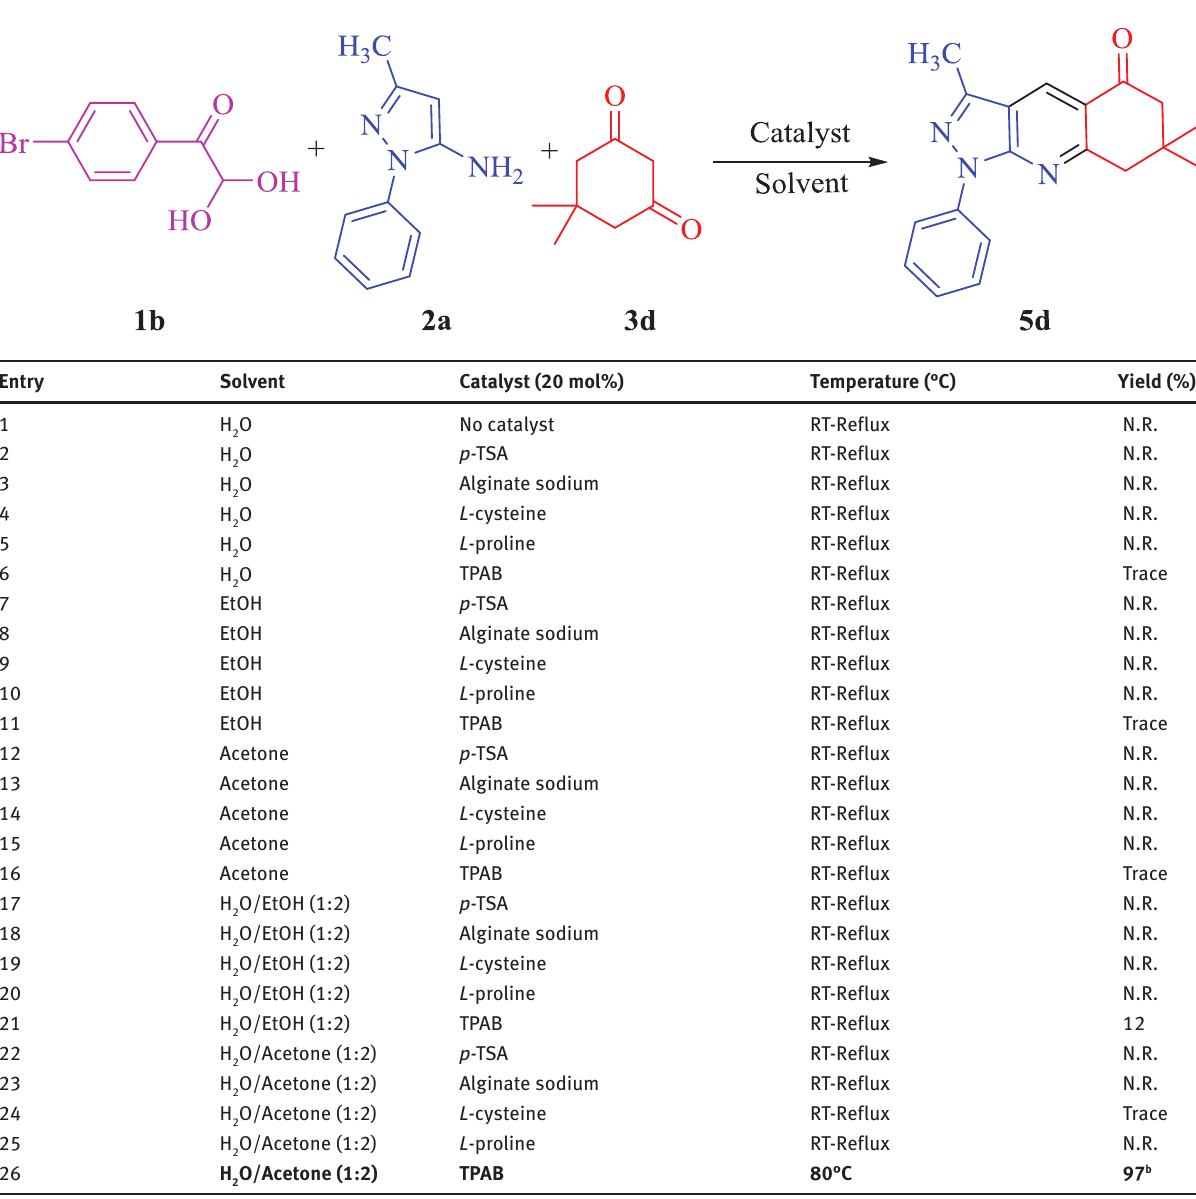
Table 1: Model reaction for the synthesis of compound 5d